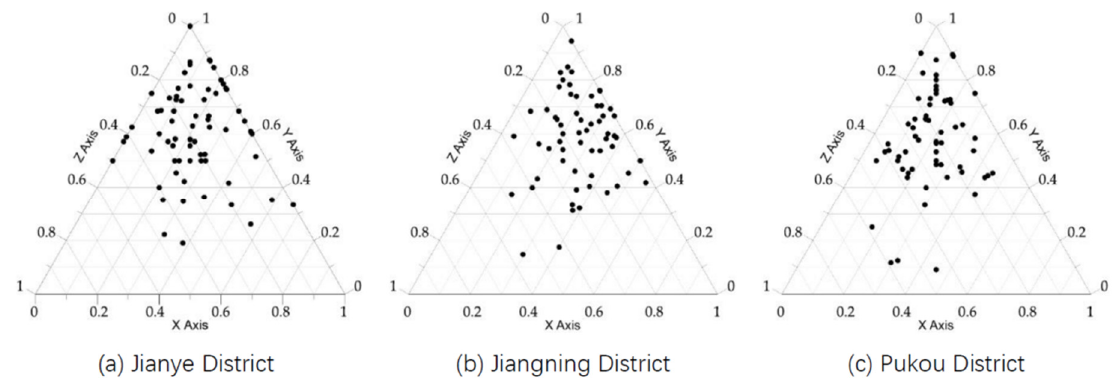
Figure 9. Node gram of the residential areas in Jiangning, Jianye, and Pukou District.